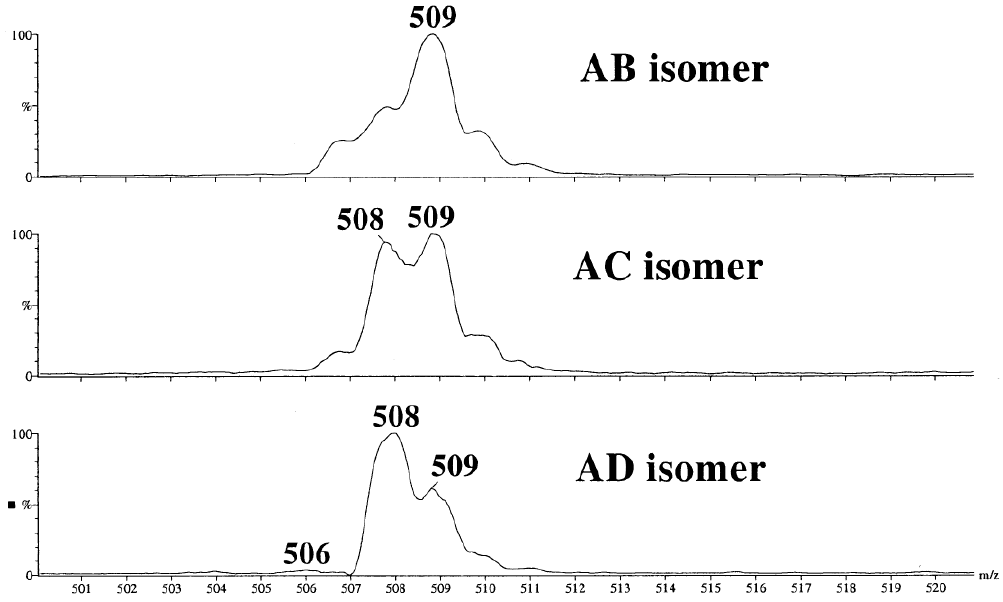
Figure 13. A characteristic part of pseudo-MS 2 of [M + Na] + of three regioisomeric 6,6 ′ -diamino β -CDs ( 9b – 11b ) (reproduced from [36] with permission of Springer Nature).